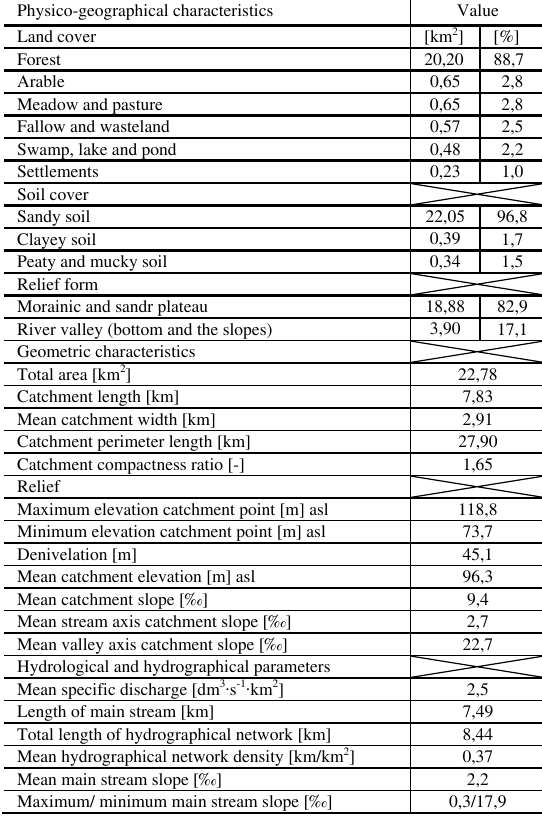
Table 3 . Selected physico-geographical parameters of Trojanka catchment Physico-geographical